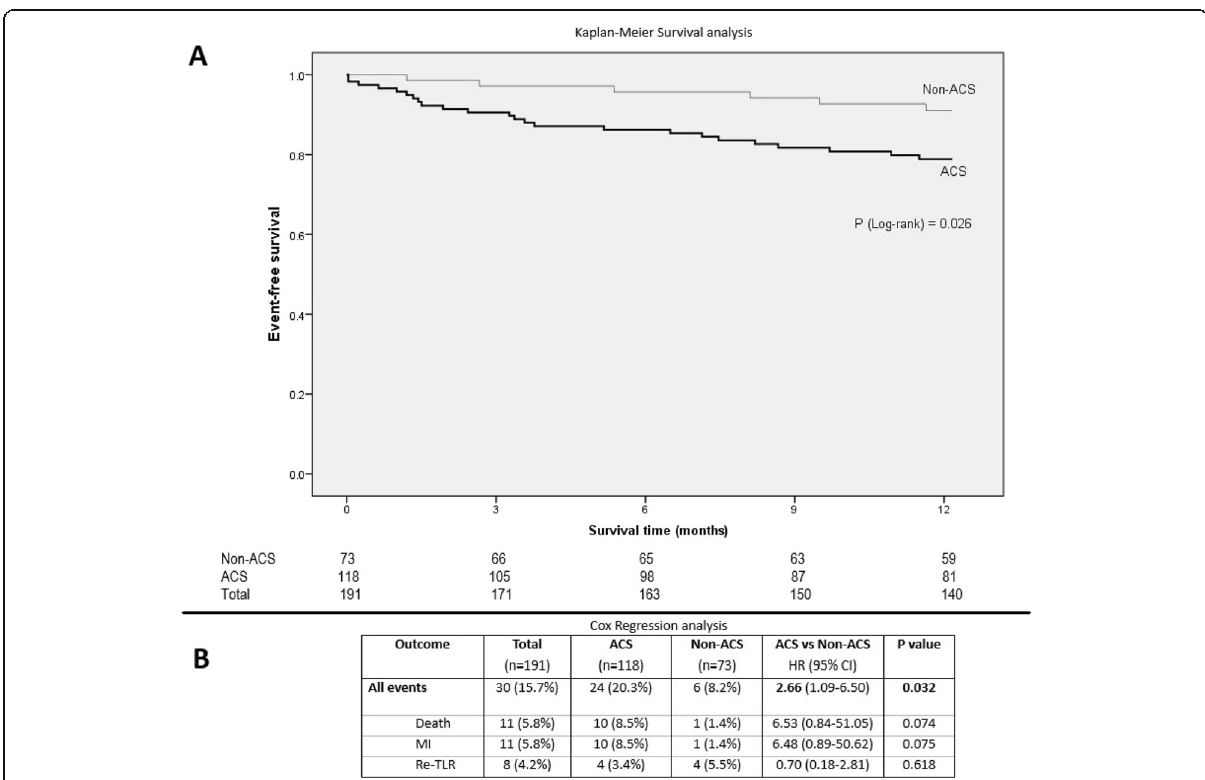
Fig. 2 Time-to-event survival analysis at 1-year according to clinical presentation of in-stent restenosis. a Kaplan-Meier survival analysis. b Cox regression analysis. ACS: acute coronary syndrome, CI: confidence interval, HR: hazard